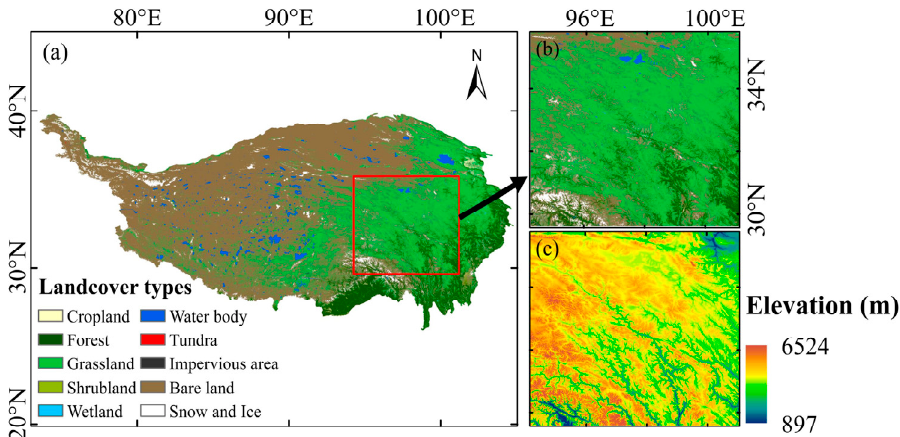
Figure 1. Map of the study area. ( a ) MODIS land cover map of the Qinghai–Tibet Plateau. ( b ) MODIS land cover map and ( c ) DEM of the study area.